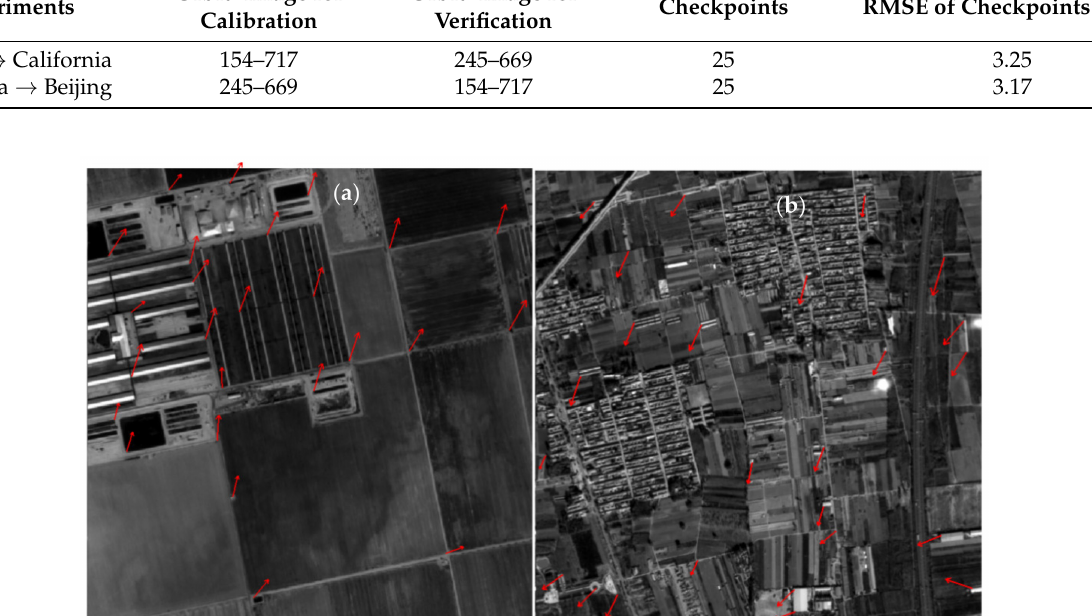
Figure 8. Residuals of the verification results of different orbit data (10 × magnification). ( a ) RMSE of Image 669: 3.25 pixels. ( b ) RMSE of Image 717: 3.17